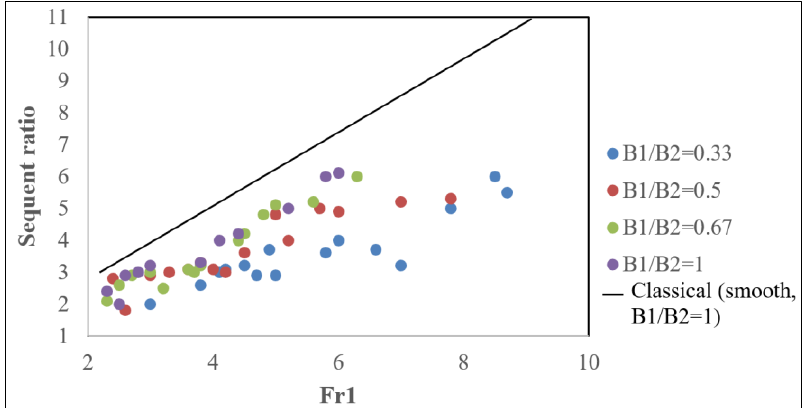
Figure 4. Sequent depth ratio in different Froude numbers and expansion ratios in the rough bed.